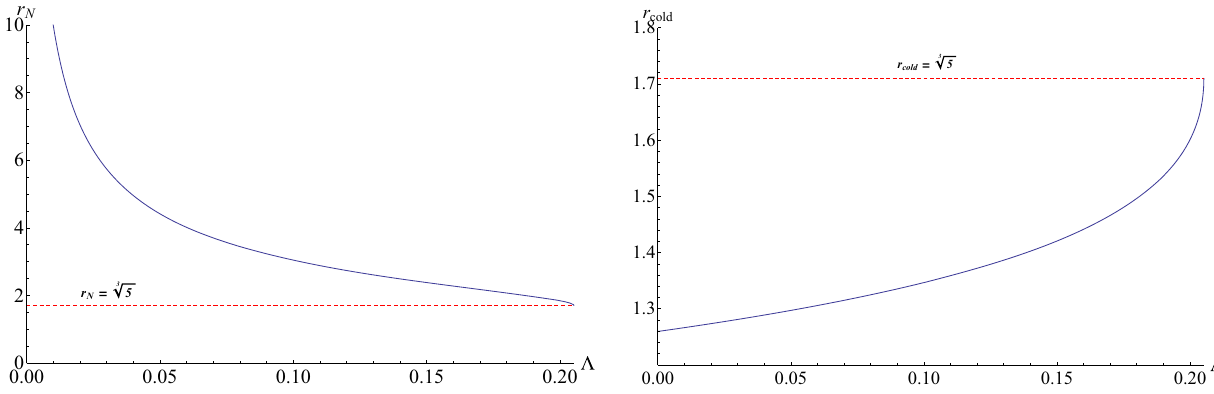
Fig. 2 We plot the event horizon radius of the Nariai black hole (left) and that of the cold black hole (right) in terms of the cosmological constant, at the magnetic charge Q = 1